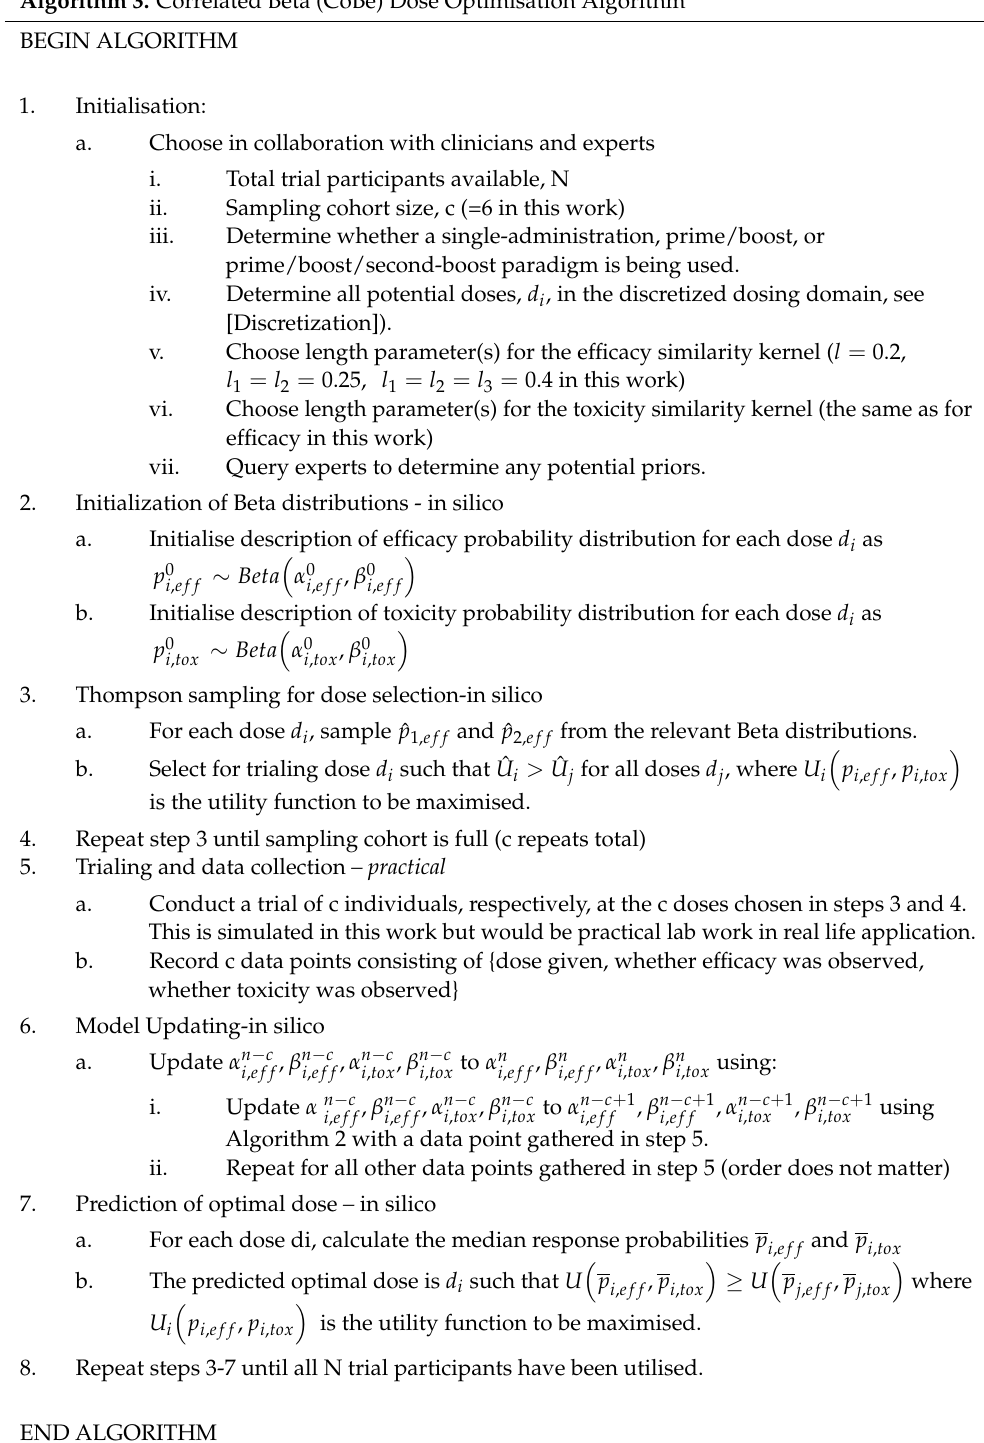
Algorithm 3. Correlated Beta (CoBe) Dose Optimisation Algorithm